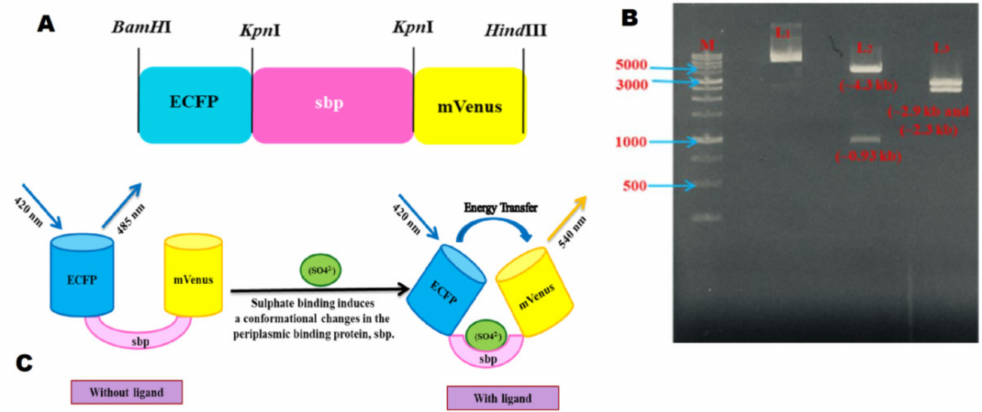
Figure 2. Schematic representation of the design of the sulfate nanosensor. ( A ) Design of restriction sites of ECFP, sbp, and mVenus; ( B ) Restriction digestion of the cloned ECFP_sbp_mVenus construct in the pRSET-B vector. M = DNA ladder, L1 = uncut plasmid, L2 = digested product with Kpn I, L3 = digested product with Bam HI and Hin dIII; ( C ) Schematic representation of working of the sulfate nanosensor. Upon binding of sulfate to sbp, ECFP and mVenus come closure, and the FRET